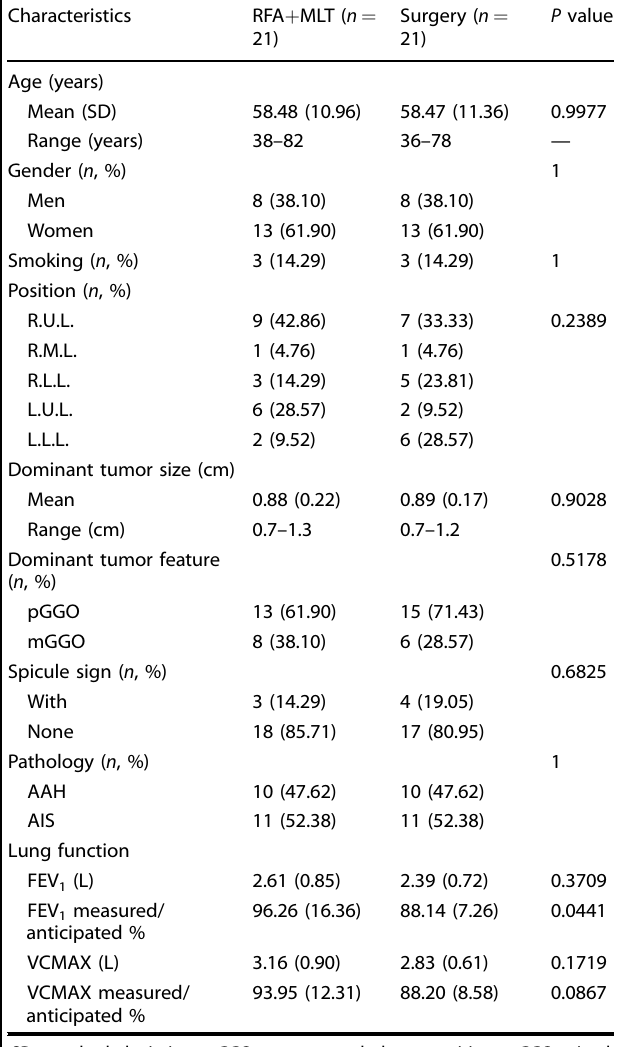
Table 1. Baseline characteristics of the patient population